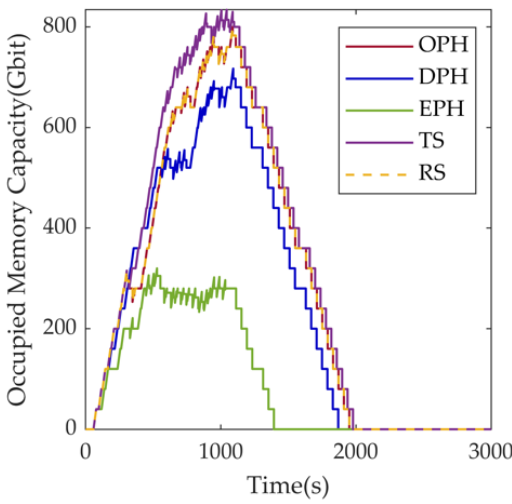
Figure 10. Satellite occupied memory capacity diagram of a single condition in the first group.